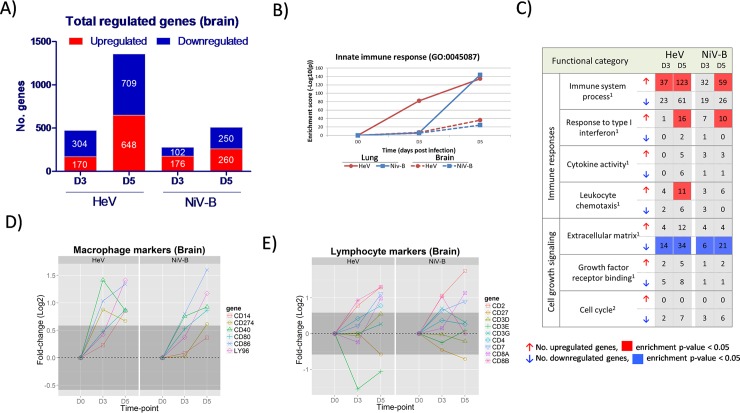
Gene expression profiles in the brain of ferrets infected with HeV and NiV-B.Ferrets were infected with 5,000 TCID50 of HeV and NiV-B and euthanized at 3 and 5 d.p.i. (n = 3 per group, except for HeV_D5 with n = 2) and together with an uninfected control group (n = 2). Transcriptomic analysis of frontal lobe tissue was performed by RNA-seq. A) Number of significantly up- and down-regulated genes with respect to the control group (fold-variation>±1.5 and FDR<0.05) at 3 and 5 d.p.i. B) Evolution of gene enrichment score (Fisher’s exact test p-value) of the Innate Immune Response category (Gene Ontology) throughout the infection. C) Functional gene classification of differentially expressed genes in the brain tissue. Regulated genes were subjected to functional classification and a selected 1Gene Ontology categories and 2KEGG Pathways that are related to the immune responses and cell growth signaling are shown. For each functional category, the number of up- and down-regulated genes and the level of significance of the enrichment (Fisher’s exact test p-value) are indicated. D-E) Evolution in the mRNA expression levels of selected macrophage markers and lymphocyte markers, respectively, during HeV and NiV-B infection in the brain tissue. Dark grey shaded areas indicate no variation with respect to the control group (<±1.5 fold-change).